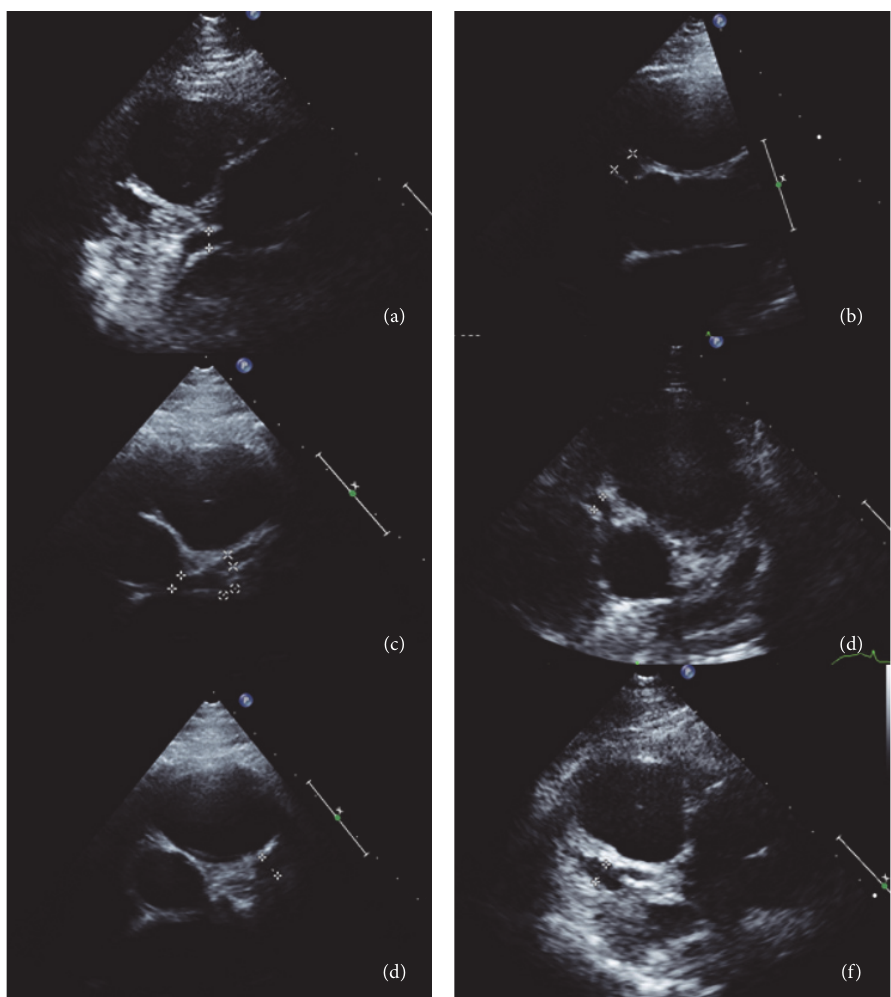
Figure 1: Echocardiographic images demonstrating coronary artery ectasia. Parasternal short axis views from echocardiogram. (a) Left coronary artery measured at proximal end. (b) Right coronary measured at proximal end. (c) LCA measured at distal end. (d) RCA measured at proximal end. (e) LCA at bifurcation into the left circumflex and left anterior descending coronary. (f) RCA measured at the distal